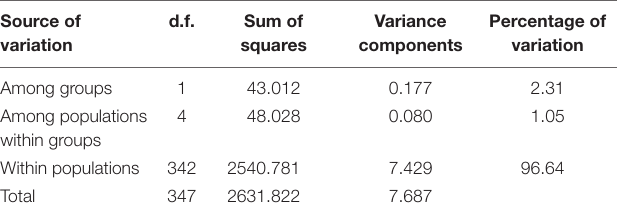
TABLE 4 | AMOVA analyses for six populations of G. divaricata divided into two groups (east and west sides of Adriatic Sea). Source of d.f. Sum of Variance Percentage of variation squares components variation Among groups 0.177 2.31